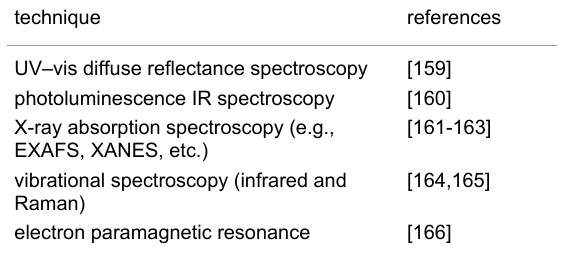
Table 4: Overview of characterization techniques for the determin- ation of Ti-coordination.